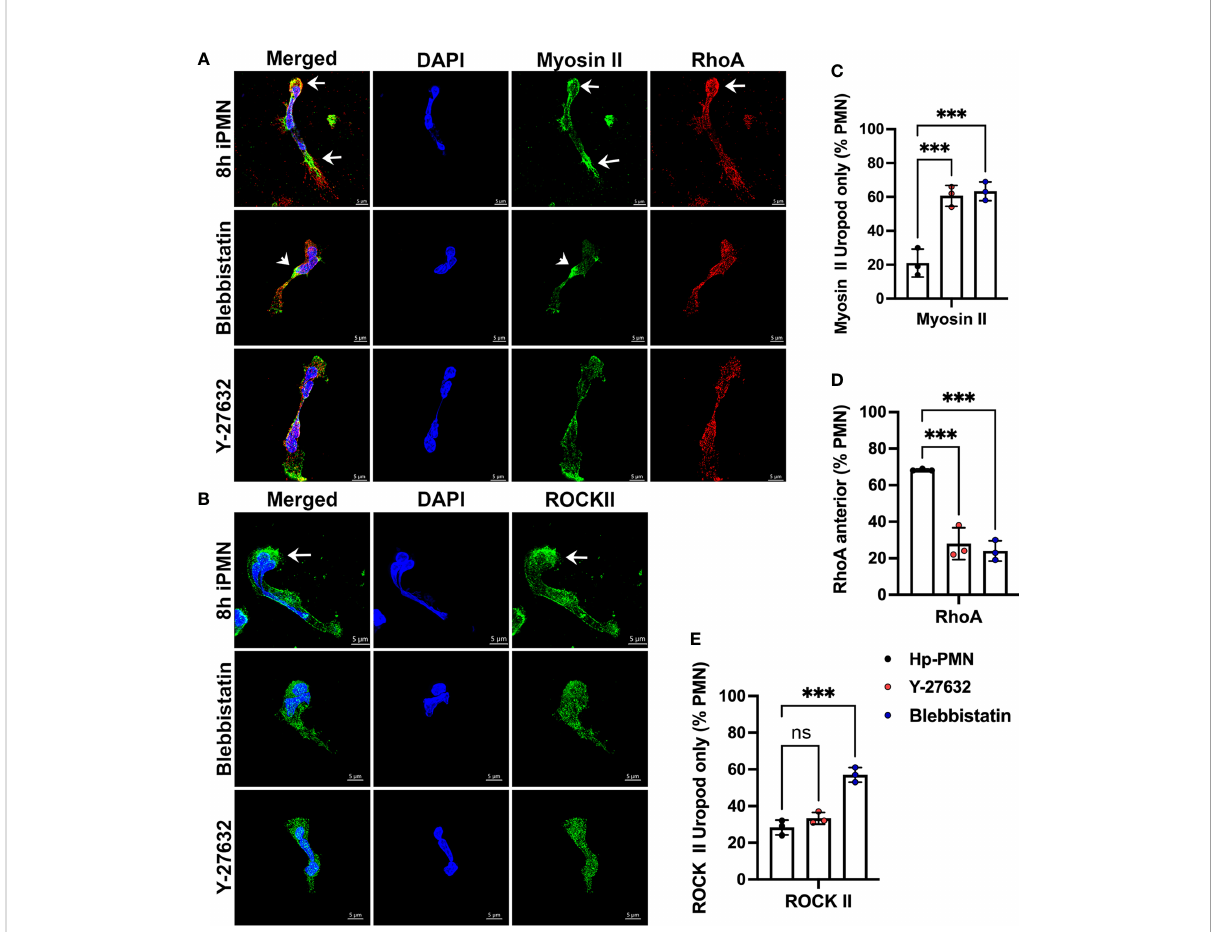
FIGURE 6 Effects of Blebbistatin and Y-27632 on localization of Myosin IIA, RhoA, and ROCK II. Freshly isolated neutrophils in MatTek ™ dishes were treated with 25 m M Blebbistatin or 15 m M Y-27632 and allowed to migrate toward fMLF. Cells infected with H . pylori for 8 hours are shown for comparison. Fixed cells were stained to detect DNA (DAPI, blue), myosin IIA (green) and RhoA (red) (A) , or DNA (DAPI, blue) and ROCK II (green) (B) . Arrows indicate protein enrichment at the front or rear of infected PMNs. Arrowheads indicate enrichment of myosin IIA directly behind the nucleus of cells treated with Blebbistatin. 3D confocal Z-stack reconstructions shown are representative of three independent experiments. Scale bar = 5 m m. (C – E) Pooled data indicate the percentage of H. pylori -infected, Y27632- or Blebbistatin-treated neutrophils at 8 hours with uropod-restricted myosin IIA (C) , anterior accumulation of RhoA (D) or uropod-restricted ROCKII (E) . At least 100 cells per experiment and condition were scored. Data are the mean ± SD (n=3). Data were analyzed by one-way ANOVA and Tukey ’ s multiple comparisons post-test. As indicated, *** p <0.001, ns, not signi fi cant. Hp-PMN, Helicobacter pylori -infected